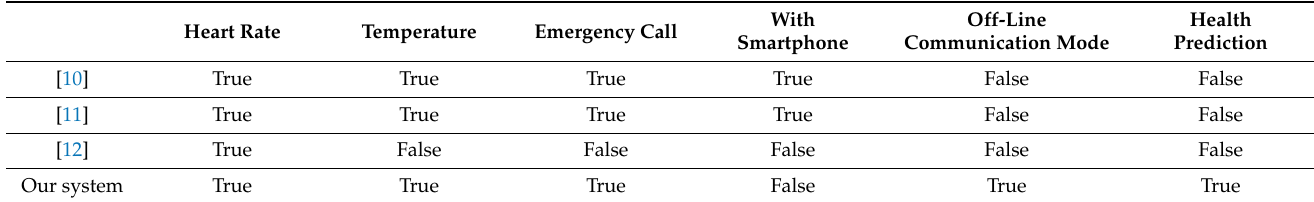
Table 1. The commercial wearable